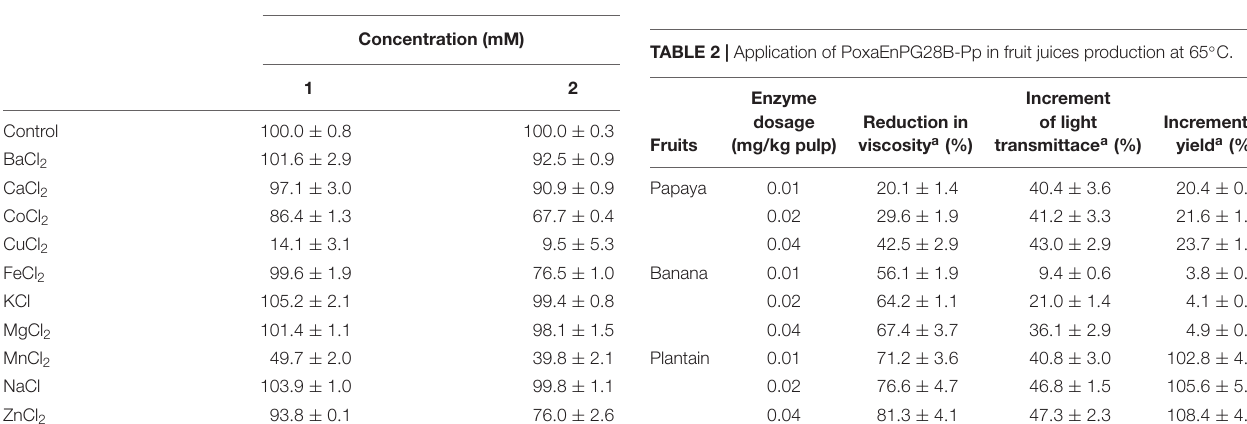
TABLE 1 | Effects of metal ions on the enzyme activity of PoxaEnPG28B-Pp. Metal salts